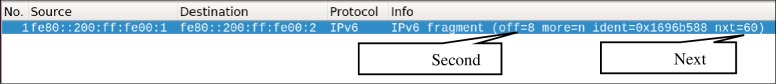
Wireshark is showing the second frgment of the packet.